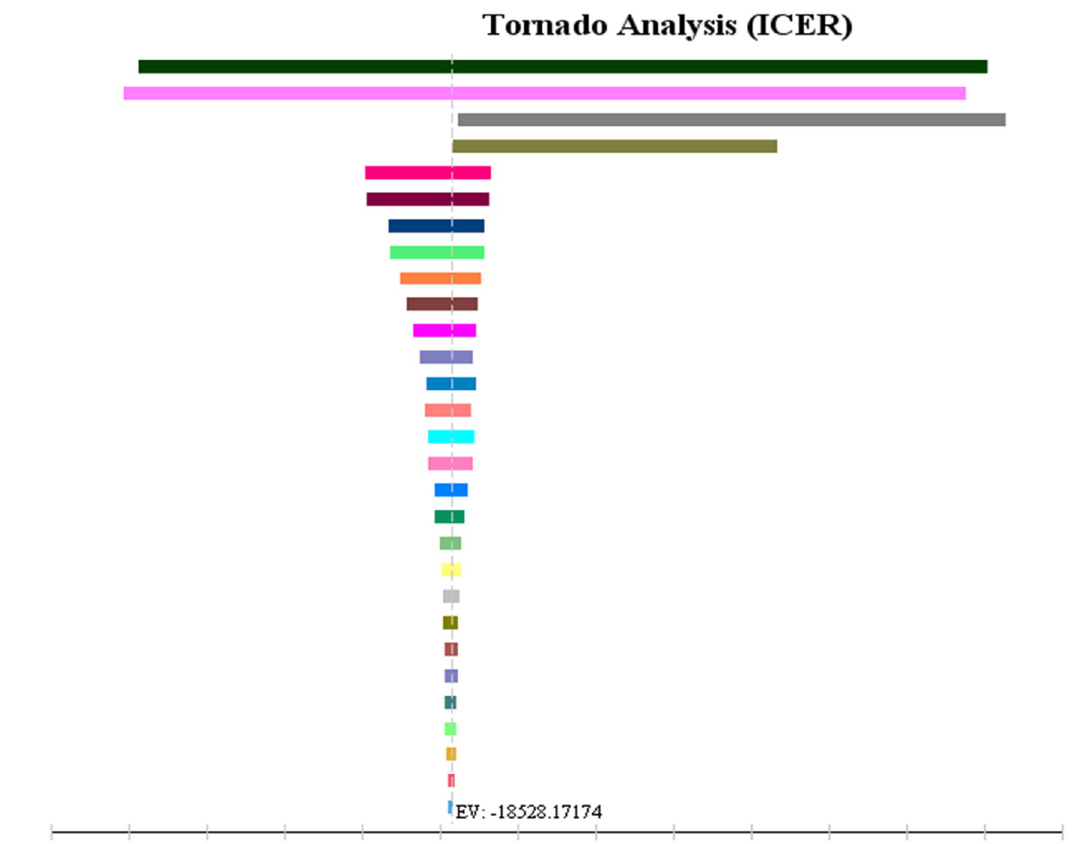
Figure 3. Tornado diagram for multiple one-way sensitivity